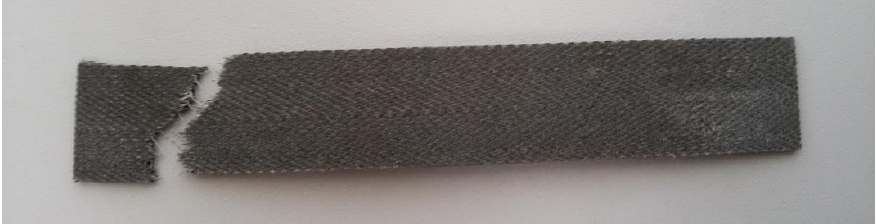
Figure 13. KKA-20-20 sample after tensile strength testing.